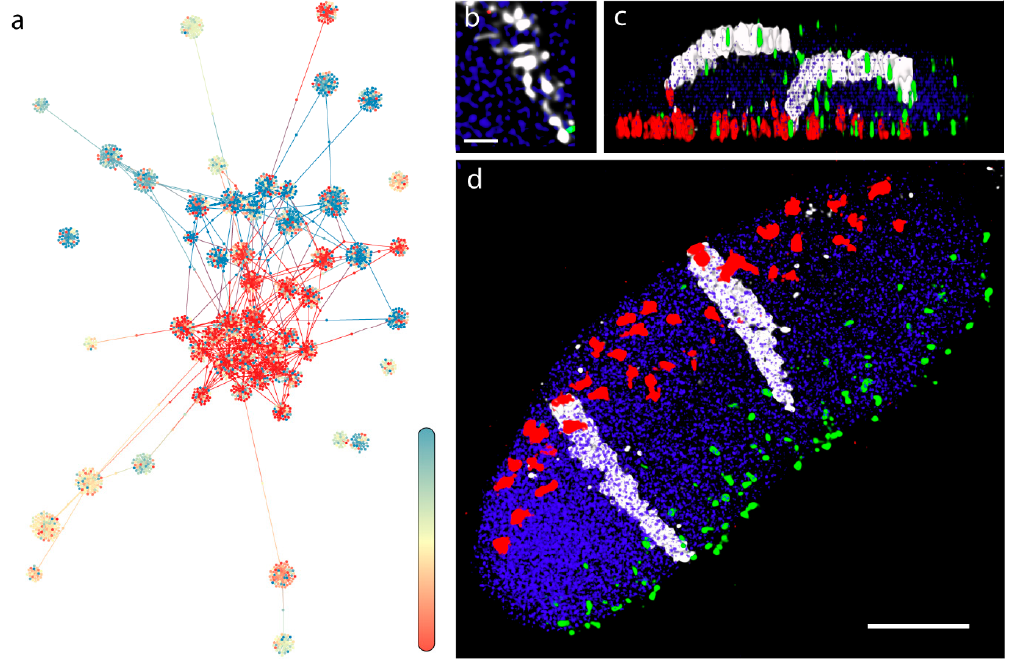
Figure 3. 2D graph representation of the contact data of chromosome 7H of barley and microscopic evaluation of the organization of an individual (long) arm of the 7H barley chromosome (7HL) within the interphase nucleus. ( a ) A 2D graph representation of contact data of chromosome 7H. Contacts are filtered for intrachromosomal and 85 hits or above. Fully saturated blue and red colors represent the two telomeric ends of the chromosome. Positions are indicated by a gradient color in between the ends, where pale yellow marks the putative location of the pericentromeric region. Contacts are clustered within each telomeric regions with a few contacts between them. The pericentromeric region is well-separated from the telomeres, a contact pattern typical of the Rabl configuration. ( b ) A high-resolution image enlargement of the 7HL chromatin threads (white) intertwined with the neighboring chromatin captured within a mitotic nucleus of the 7BS-7HL wheat-barley translocation line with confocal laser-scanning microscopy. The 7BS-7HL wheat-barley translocation line carries the 7HL barley chromosome arms stably transferred into the wheat background, allowing the 3D visualization of the barley chromatin by genomic in-situ hybridization (GISH). ( c ) Side view of a three-dimensionally rendered z-stack captured from a mitotic nucleus of the 7BS-7HL wheat-barley translocation line. The 7HL barley chromatin is detected by GISH (shown in white), centromeres are visualized by simultaneous immunolabelling (red) and telomeres are shown by fluorescence in-situ hybridization (green). ( d ) Front view of the same three-dimensionally rendered z-stack, showing parallel arrangement of the two homologous 7H long arms. Rabl organization is clear from the polarized centromere (red signals)-telomere (green signals) arrangement and the signal of the perpendicularly running barley chromosome arms. Bar = 5 µ m, except Figure 3b where bar represents 1 µ